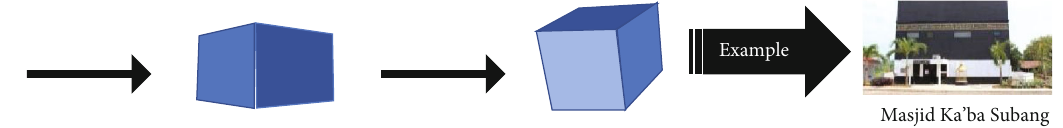
Figure 29: House diagrams of simple house